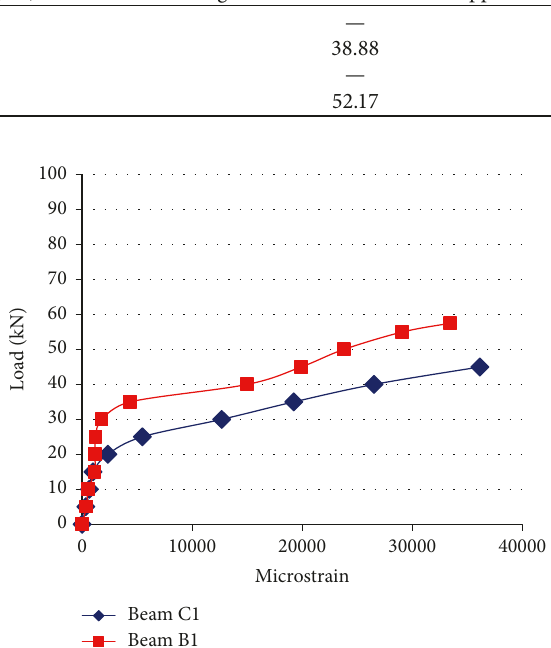
Figure 12: Effect of clear span length of the beam on load-strain response without carbon fiber strengthening.